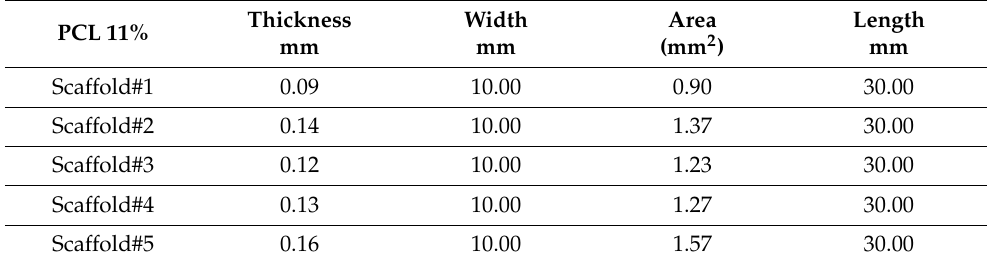
Table 3. Properties of unaligned PCL scaffolds for mechanical characterization.